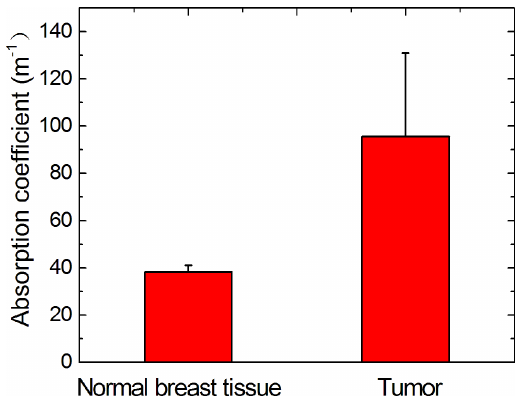
Fig. 2. Microwave absorption coe±cient of normal breast tissue and